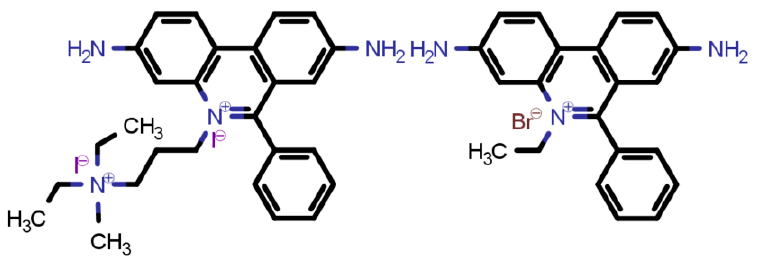
Figure 5. Structures of propidium iodide ( left ) and ethidium bromide ( right ), non-membrane permeable, fluorescent agents that stain by DNA intercalation.